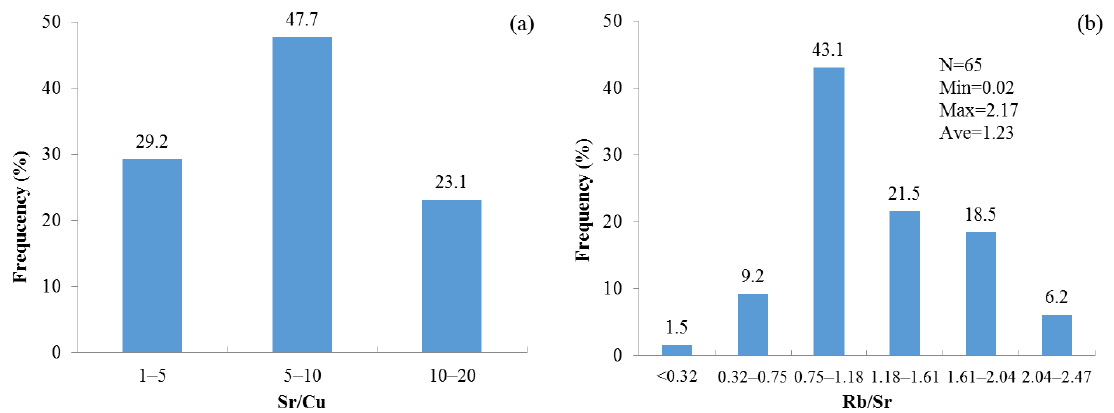
Figure 3. Trace element distribution patterns of the mudstones of the Neogene Guantao Formation in the Liaodong sub-uplift (data are normalized by the average mudstone values listed in Table 2).